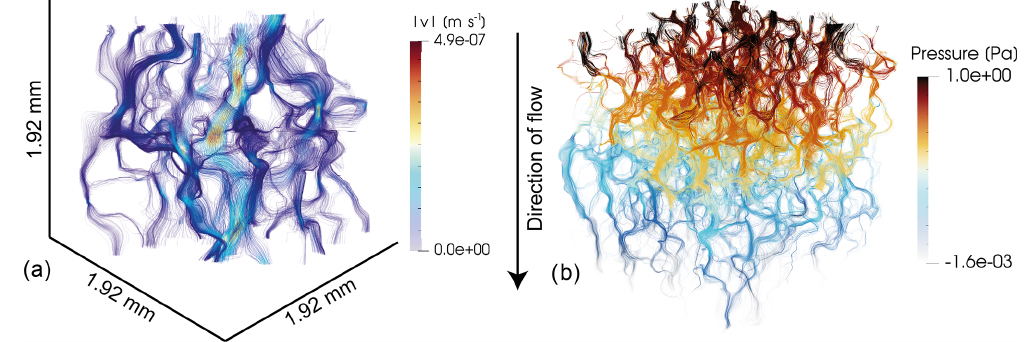
Figure 7. Newtonian fluid flow through the Fontainebleau sandstone sample. Streamlines colored using computed fluid velocities are shown in panel (a) and streamlines colored using fluid pressures are shown in panel (b) .